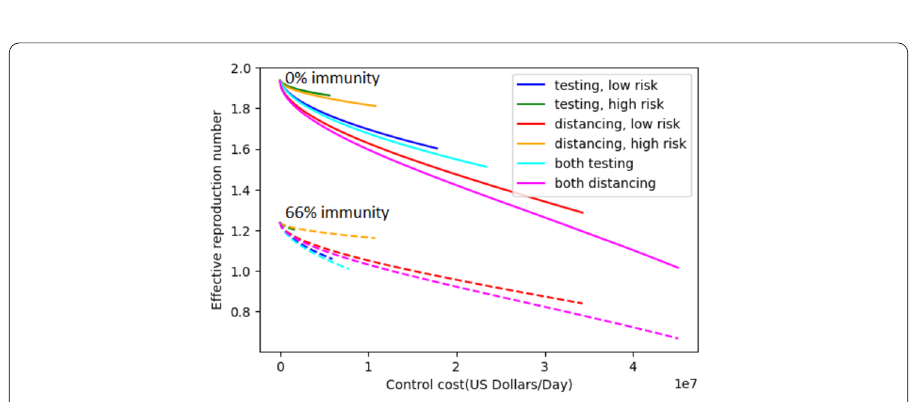
Figure 4 Dependence of R e on daily implementation cost for six strategies at 0% and 67%